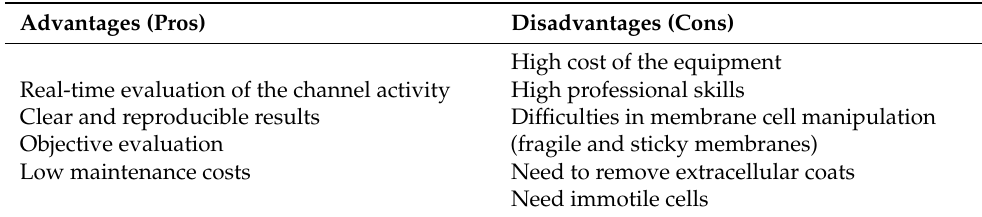
Table 1. Advantages and disadvantages associated with the application of the electrophysiological technique in gametes and early